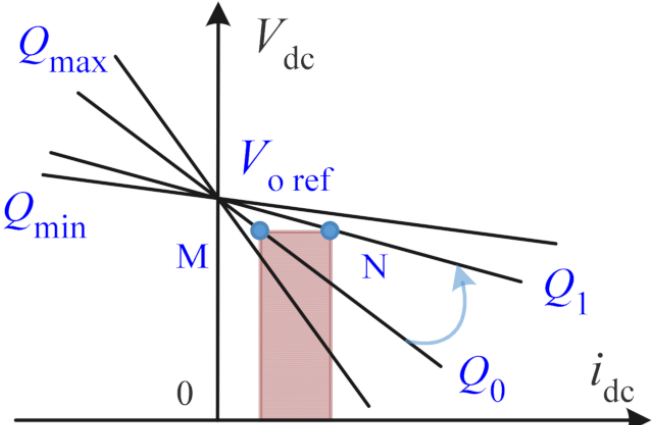
Figure 3. Variation curve clusters of droop